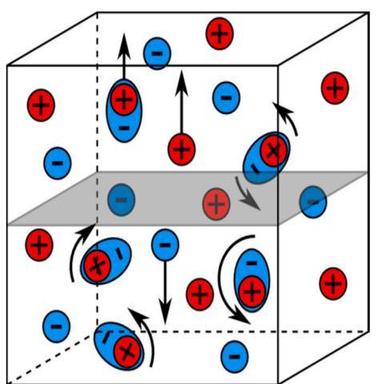
Sample response to exciting alternating electric fields.